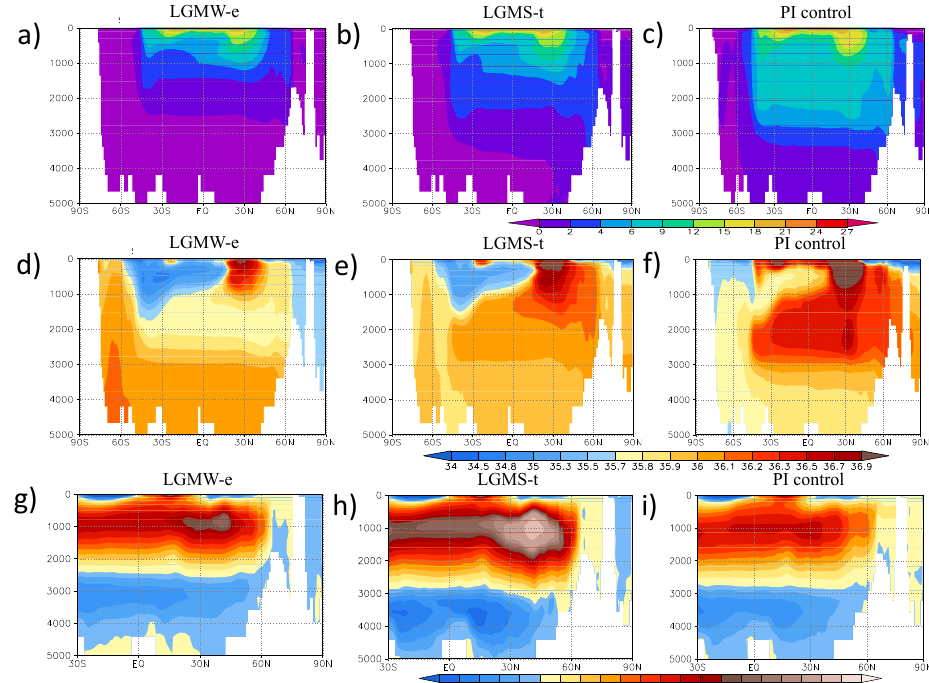
Fig. 7. Meridional section of zonal mean temperature ( (A–C) , units: ◦ C), salinity ( (D–F) , units: psu) and stream function ( (G–I) , units: Figure 7. Meridional section of zonal mean temperature (A-C, units: °C), Sv (10 6 m 3 s − 1 )) in the Atlantic Ocean. For panel (F) , we added 1psu to the salinity field for a better comparison with the glacial salinity salinity (D-F, units: psu) and stream function (G-I, units: Sv (10 6 m 3 /s)) in the Atlantic Ocean. For panel (F), we added 1 psu to the salinity field for a better comparison with the glacial salinity structure.